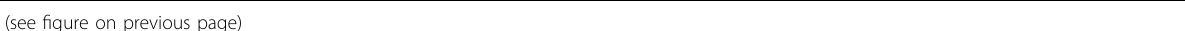
Fig. 4 Loss of p97 downregulates c-MYC and SKP2. a Immunoblotting analysis of SOX2 from the MDA-MB-231 cells treated with Eer I or NMS-873. GAPDH serves as a loading control. b Immunoblotting analysis of c-MYC from Eer I and NMS-873 treated MDA-MB-231 cells. GAPDH serves as a loading control. c Immunoblotting analysis of c-MYC from the MDA-MB-231 cells with p97 silenced. β -actin serves as a loading control. d c-MYC expression correlates with that of p97 in human breast cancer tissues. Left: representative immunohistochemical staining of c-MYC and p97 in the consecutive serial sections of breast cancer tissues. c-MYC and p97 expressions were classi fi ed as low and high. Bar: upper 200 μ m, lower 50 μ m. Right: correlation analyses of c-MYC and SOX2 expression in breast cancer tissues ( n = 98). e , f Immunoblotting analysis of SKP2 from Eer I and NMS- 873 treated MDA-MB-231 cells or MDA-MB-231 cells with p97 silenced. GAPDH serves as a loading control. g SKP2 expression correlates with that of p97 in human breast cancer tissues. Left: representative immunohistochemical staining of SKP2 and p97 in the consecutive serial sections of breast cancer tissues. SKP2 and p97 expressions were classi fi ed as low or high. Bar: upper 200 μ m, lower 50 μ m. Right: correlation analyses of SKP2 and p97 expression in breast cancer tissues ( n = 75). h Immunoblotting analysis of SOX2 and SKP2 from mammospheres and adherent MDA-MB-231 cells. β -actin serves as a loading control. i Immunoblotting analysis of SOX2 and SKP2 from mammospheres with SKP2 silenced. β -actin serves as a loading control. j Mammosphere formation of MDA-MB-231 cells with SKP2 silenced. Left: the number of spheres under each treatment. Right: representative images. Bar: upper 100 μ m. Data were shown as mean + SD. *** P <